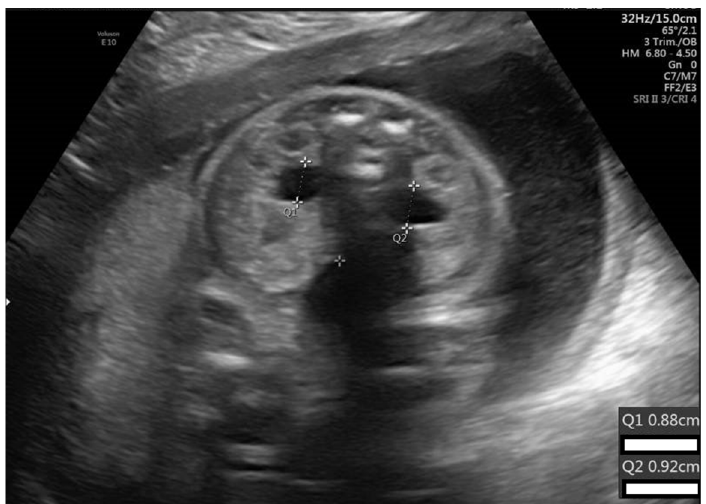
Figure 2. Axial plane image of bilateral pyelectasis at 24 weeks of gestation (8.8 mm, 9.2 mm).